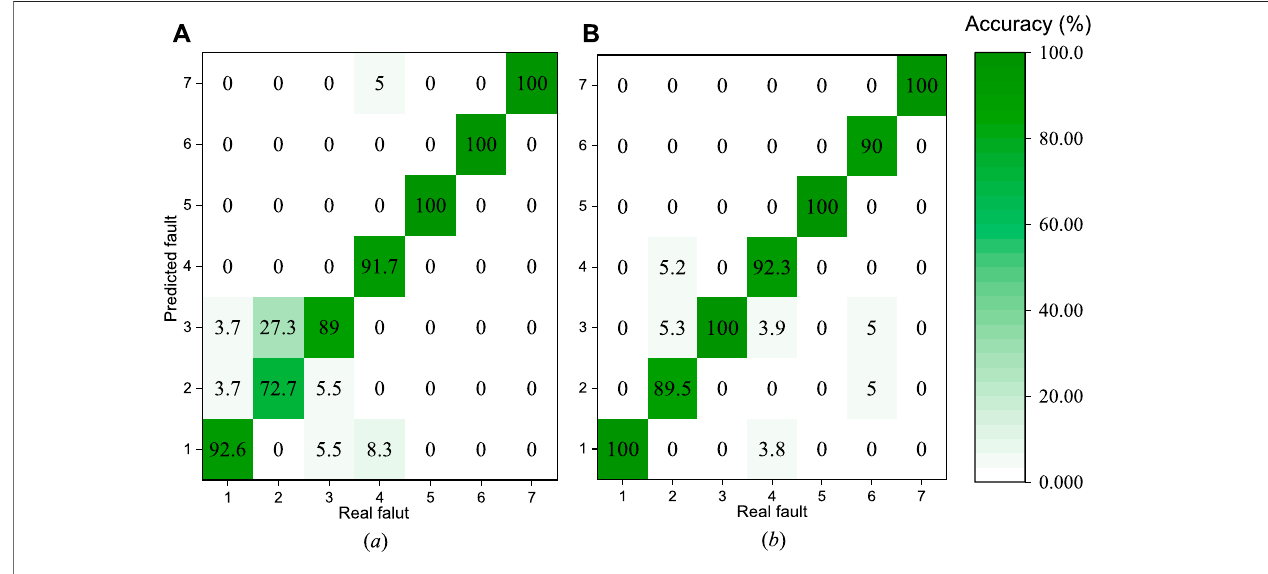
FIGURE 5 | Fault diagnosis results for the proposed methods optimized by: (A) PSO, (B) GSA.